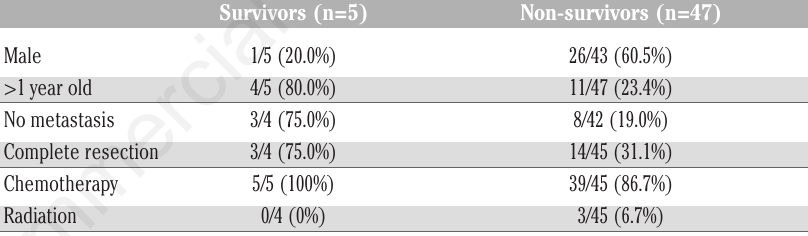
Table 1. Comparison between survivors and non-survivors of malignant rhabdoid tumor.